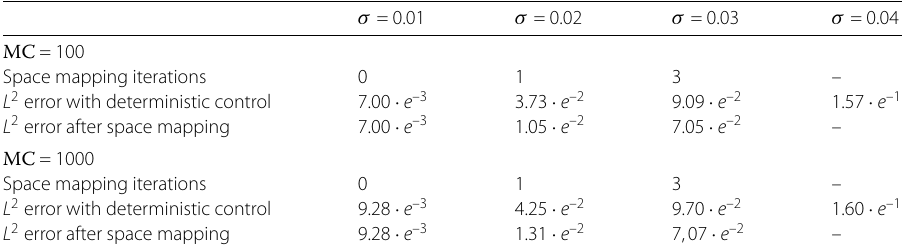
Table 1 Numerical investiation of the space mapping procedure. For σ = 0.01 no space mapping is needed, the optimal deterministic control is accepted. The number of space mapping steps increases with increasing stochastic strength. The L 2 -error of the trajectory of the center of mass compared to the center of mass of the optimal deterministic solution increases as well for larger σ . The space mapping procedure is decreasing the error by a factor three for σ = 0.02. As the stochastic starts to superimpose the crowd behaviour for σ ≥ 0.03, we see that the space mapping approach decreases the error only marginally. The second part of the table shows results obtained with 1000 Monte Carlo samples. The values change only slightly, which justifies to fix the number of MC samples to 100 for the following computations σ = 0.01 σ = 0.02 σ = 0.03 σ =